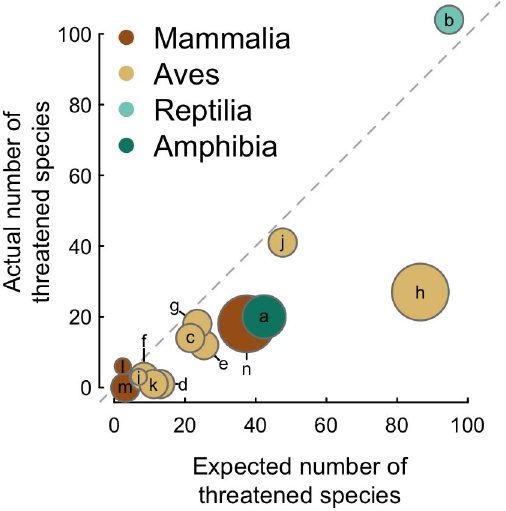
Figure 2. Expected versus actual number of threatened species per taxonomic order in ISIS zoos for each taxonomic class of terrestrial vertebrates. Each point represents an order that was significantly different from the expected value if zoo collections were taken at random. The size of the point corresponds to the number of threatened species for each order. Labels correspond to: a) Caudata; b)